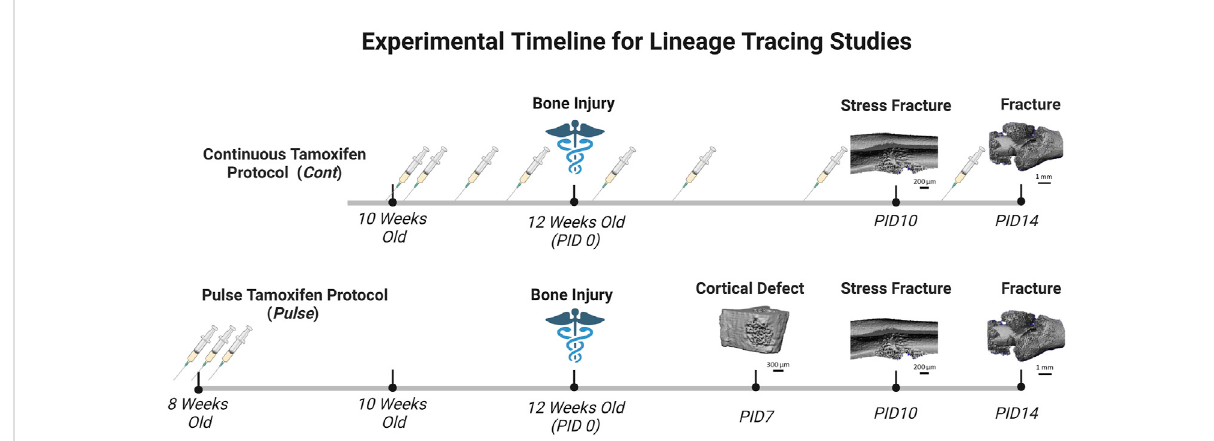
FIGURE 2 Timeline of Pulse Versus Continuous Dosing During Bone Repair. Mice were either given tamoxifen by oral gavage (syringe icon in Figure 2) (TMX; 100 mg/kg) continuously (2 days/wk) starting at 10 weeks old, or pulsed with TMX for three consecutive days starting at 8 weeks old. Then mice underwent bone injury via semi-stabilized femoral fracture, ulnar stress fracture or tibial defect injury at 12 weeks. Mice were sacri fi ce at pre- de fi ned timepoints corresponding with robust woven bone formation for each injury model (microCT reconstruction for woven bone; day 7 defect; day 10 stress fracture; day 14 femoral fracture). Days post-injury (PID) are subsequently labeled. Figure created in Biorender.